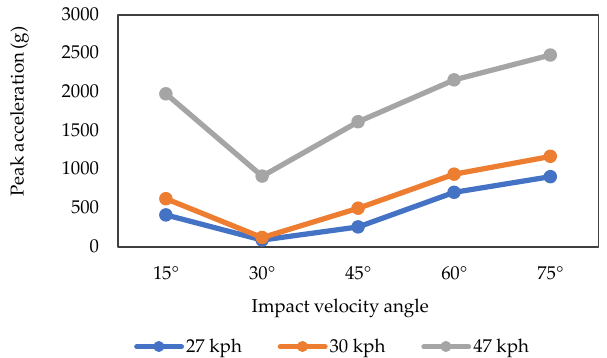
Figure 18. Simulation results of peak acceleration of case III.